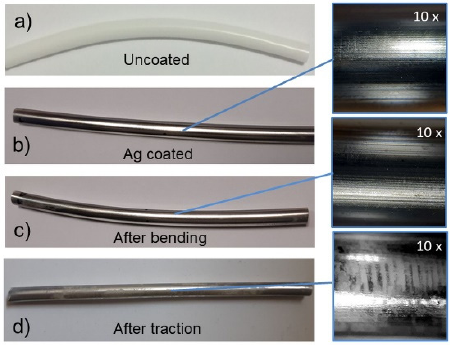
Figure 4. Optical images of the CVC before ( a ) and after ( b ) deposition. Moreover, optical images of the coated device were also acquired after tensile ( c ) and bending test ( d ). On the right, magnified images highlight details of the respective surfaces.